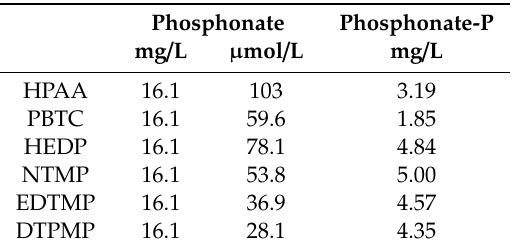
Table 2. Di ff erent concentrations of phosphonates used in Experiment 1. Phosphonate Phosphonate-P